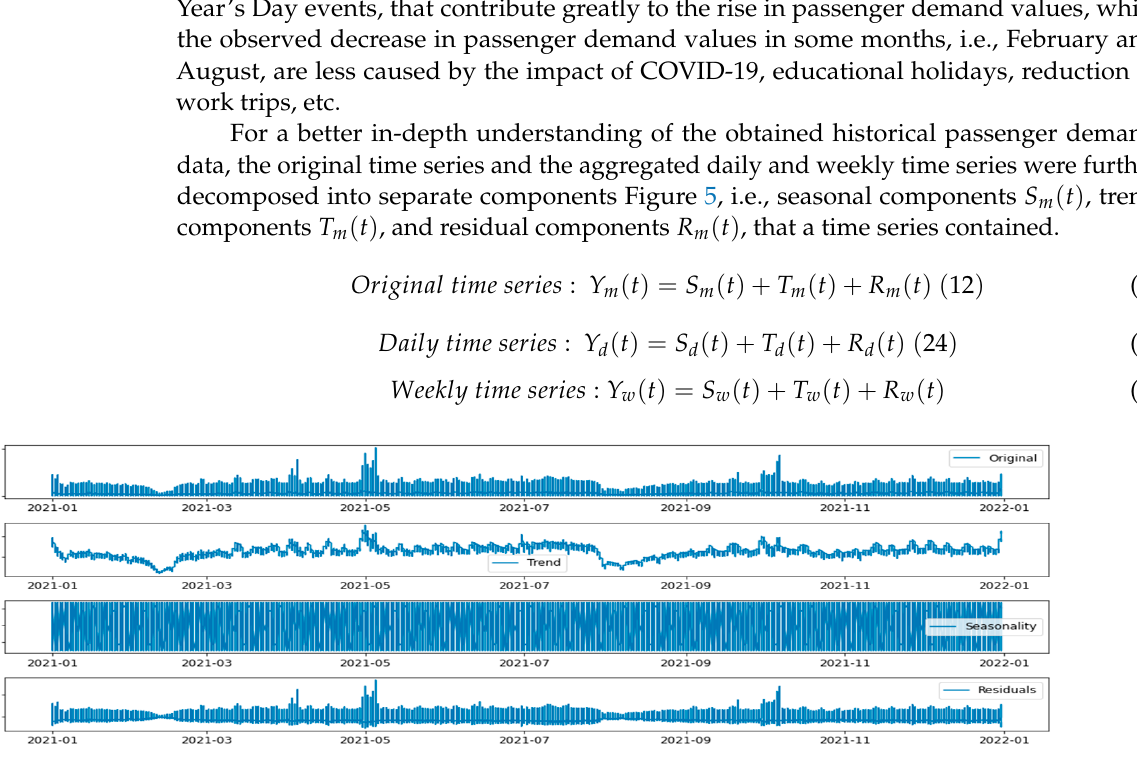
Figure 4. Weekly training and test datasets .